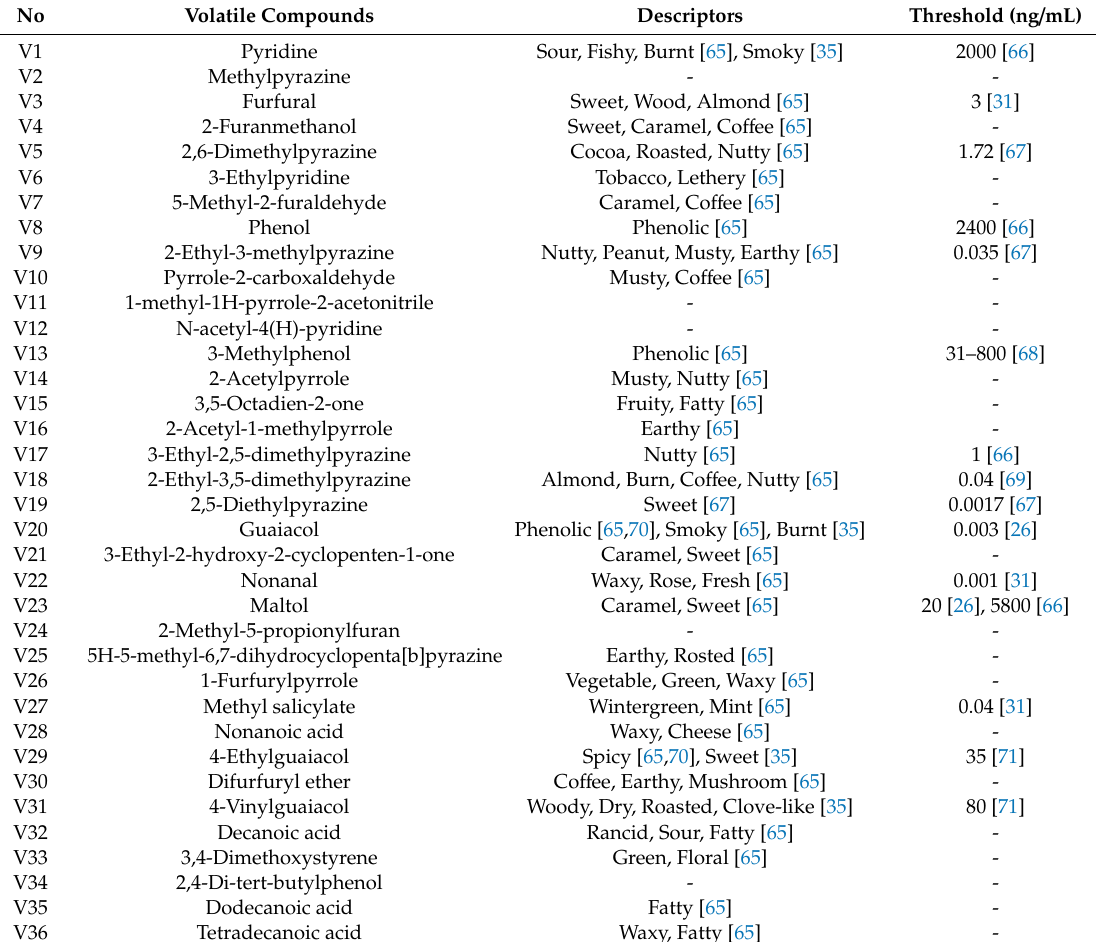
Table 6. Sensory descriptors and odor threshold value of volatile compounds of co ff ee